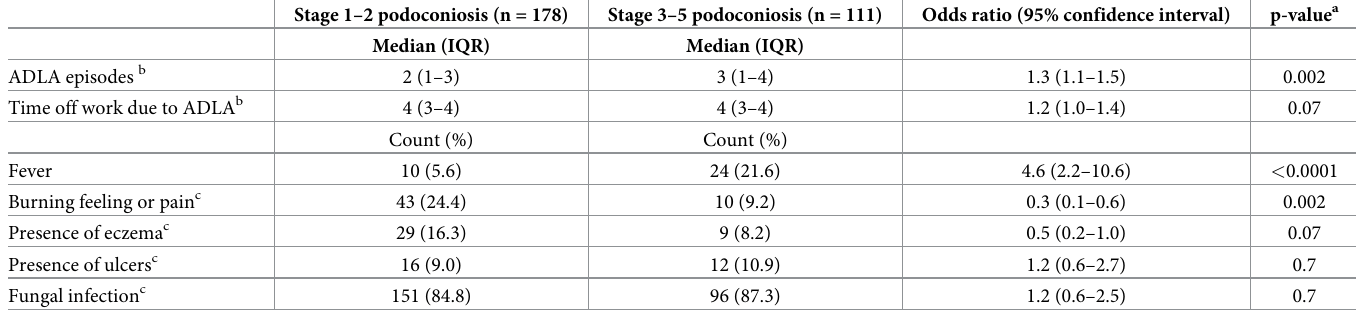
Table 3. Associated morbidity of stage 1–2 versus stage 3–5 podoconiosis in Durbete Podoconiosis Prevention and Treatment Centre, Durbete, Ethiopia, February 2018 to October